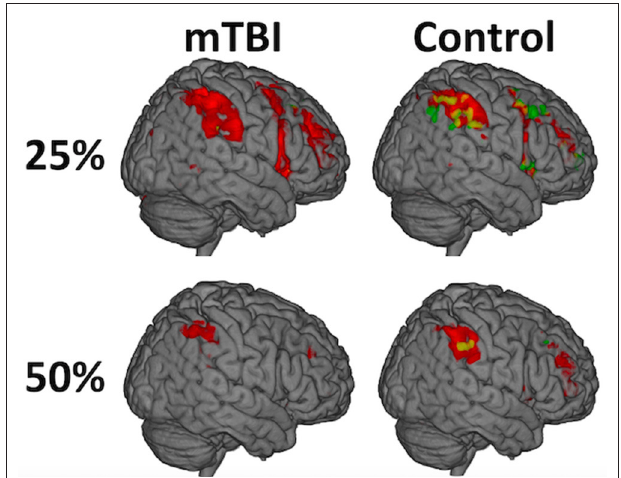
FIGURE 2 | While there was not a significant Time on Task-by-group interaction (A = mTBI; B = Control), the distribution of activity during the first half (red) relative to the second half of each trial (green) differed between the groups and was most evident at the 25% effort level such that the mTBI group had little to no suprathreshold activity in the second half of each trial while the Control group did. The distribution of the effect, and the amount of brain activation, decreases over the duration of the experiment (e.g., from 25 to 50%) in both groups and is only seen in the left postcentral gyrus at 75%, likely secondary to habituation to the ask over